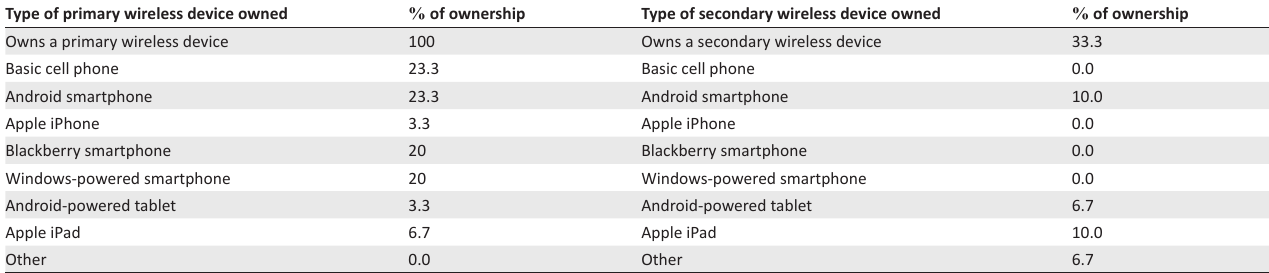
TABLE 3: Ownership of primary and secondary wireless device(s) ( N =